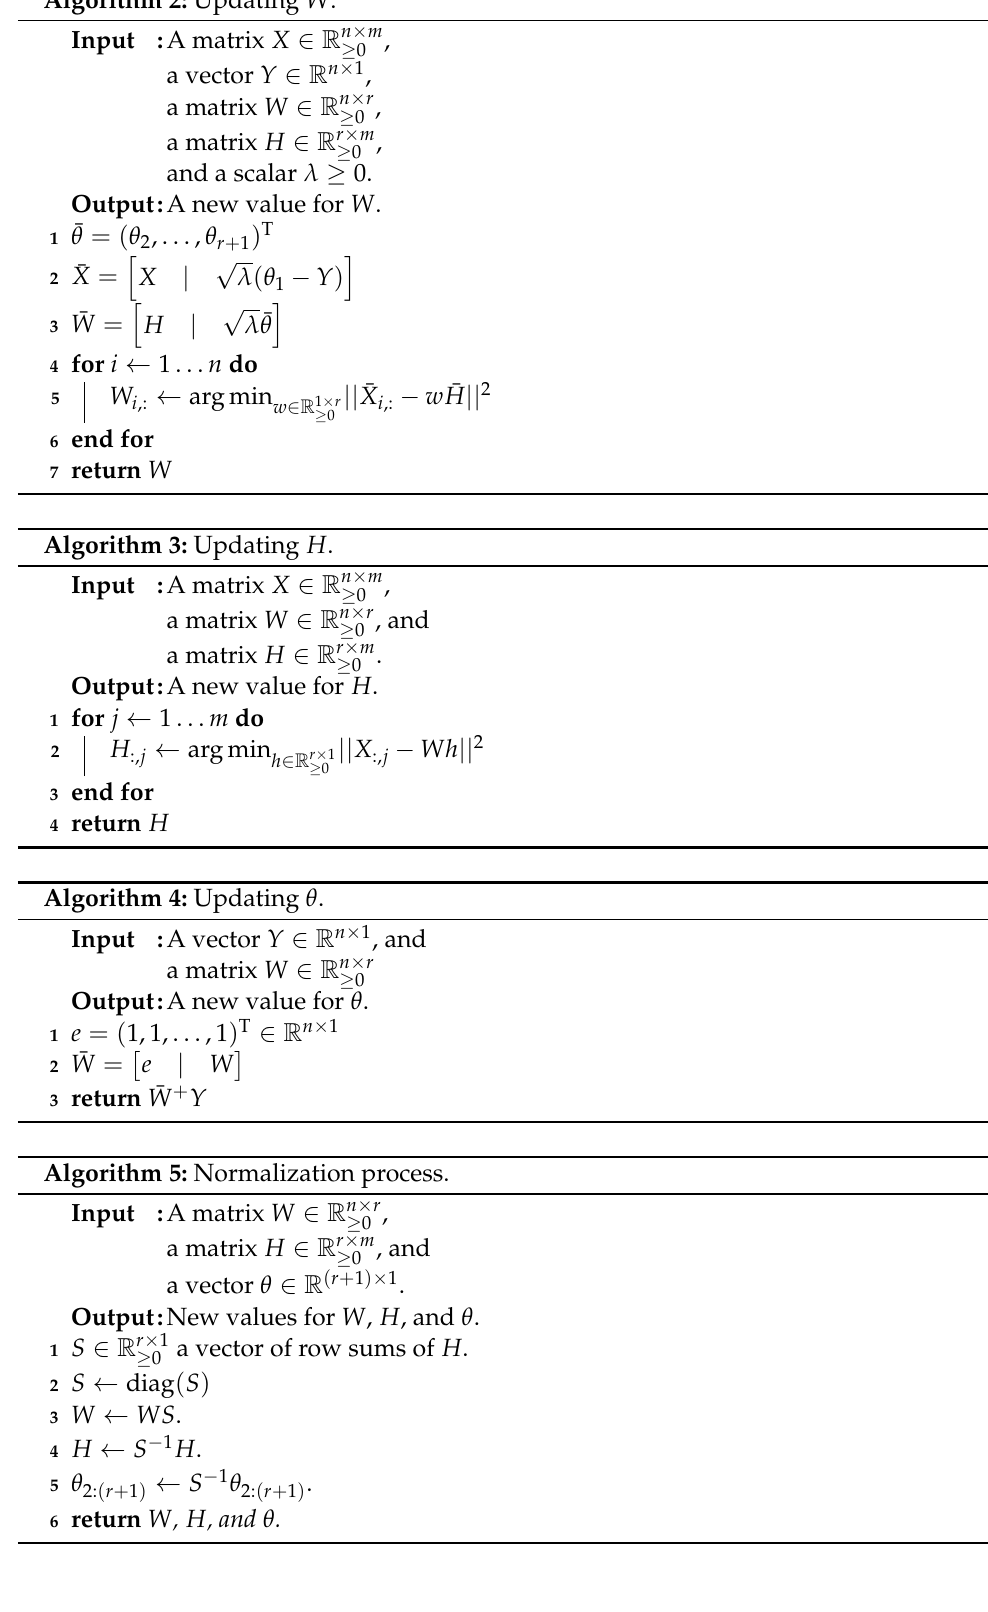
Algorithm 2: Updating W .